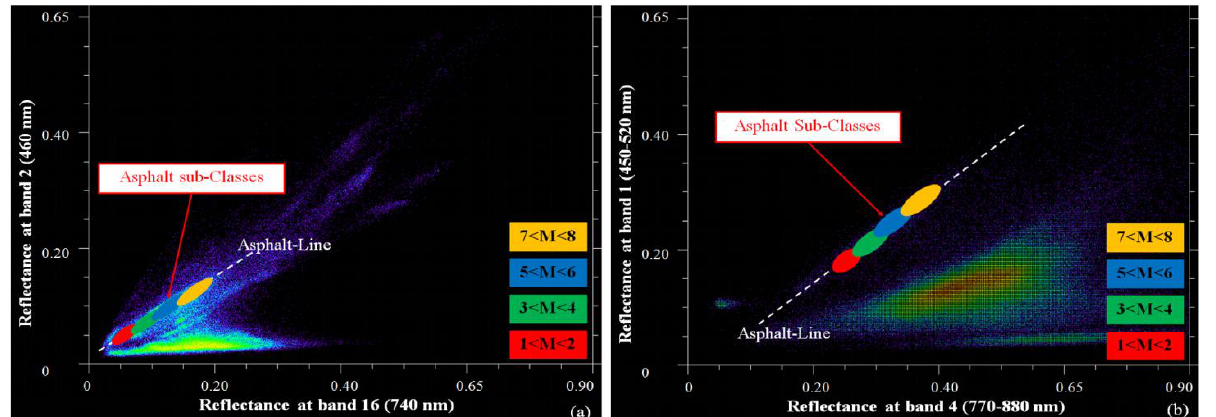
Figure 7. ( a ) Asphalt sub-classes in MIVIS imagery and ( b ) in Quickbird